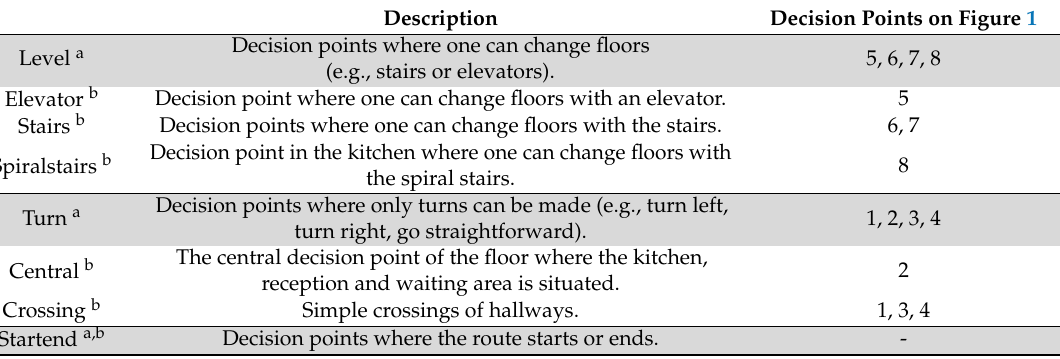
Table 4. Categorization of decision